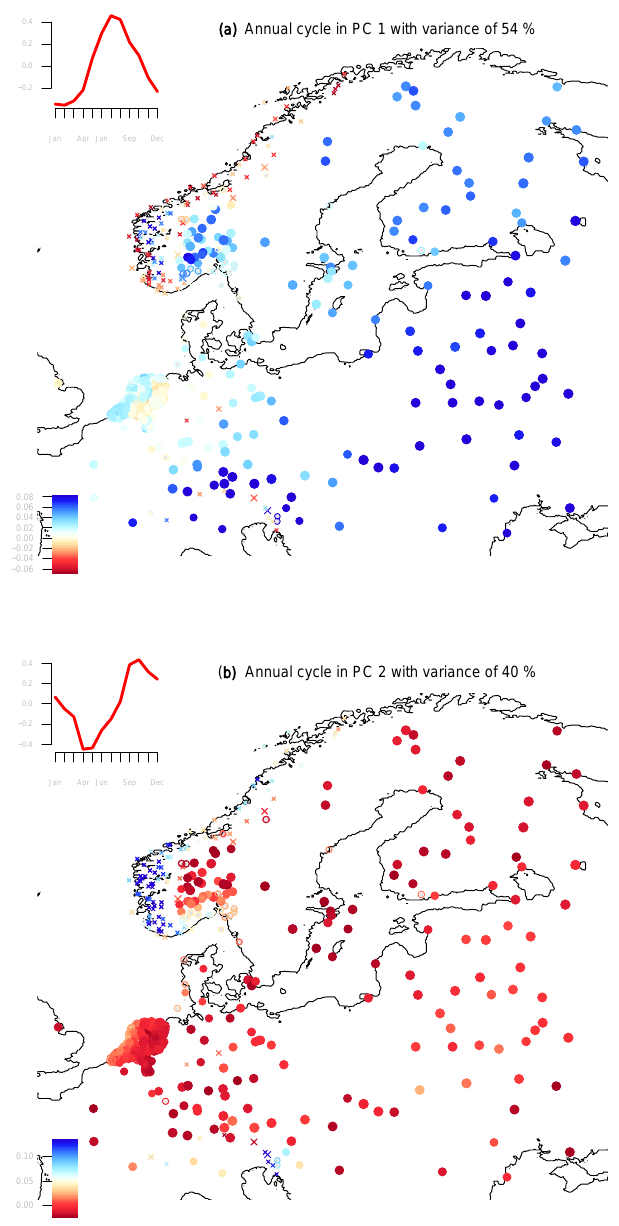
Figure 2b Figure 2. The weights for the two leading principal compo- nents (a, b) of the seasonal cycle of the wet-day mean precipita- tion µ in the 1032 rain gauge records. The colour of the symbols indicates how strongly the shape is present in the local seasonal cy- cle, and the size reflects R 2 from the regression analysis between e s and µ (see Fig. S5). Filled circles were used for locations with R 2 > 0 . 6, hollow circles for 0 . 6 ≥ R 2 > 0 . 4 and crosses indicate locations with R 2 < 0 . 4. The shape of the seasonal cycle principal component for µ is shown in the inset (top left of each panel).